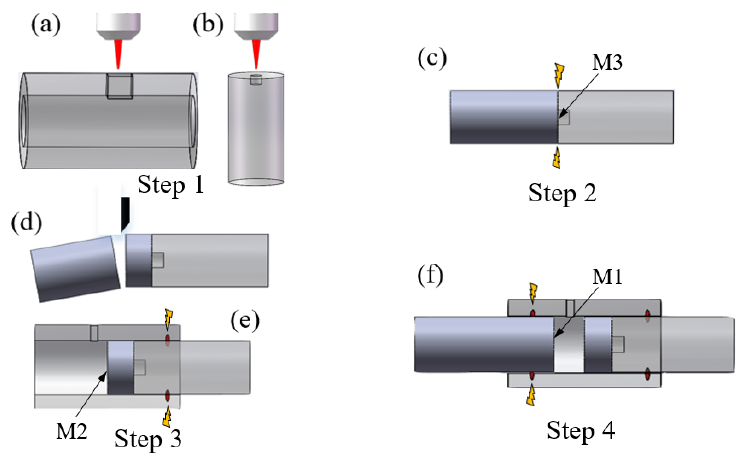
Figure 3. Schematic of the fabrication process of the EFPI gas pressure sensor: ( a , b ) micromachining of capillary tube and SMF; ( c ) fusion splicing of drilled SMF to an intact SMF; ( d ) cleaving of the spliced structure; ( e ) fusing with capillary tube; ( f ) inserting and fusing of another SMF (LSMF) in the capillary tube.